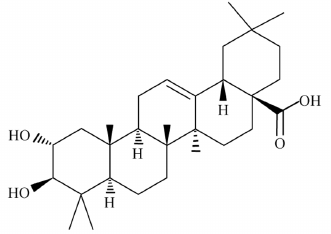
Figure 1. Structural formula of MA.